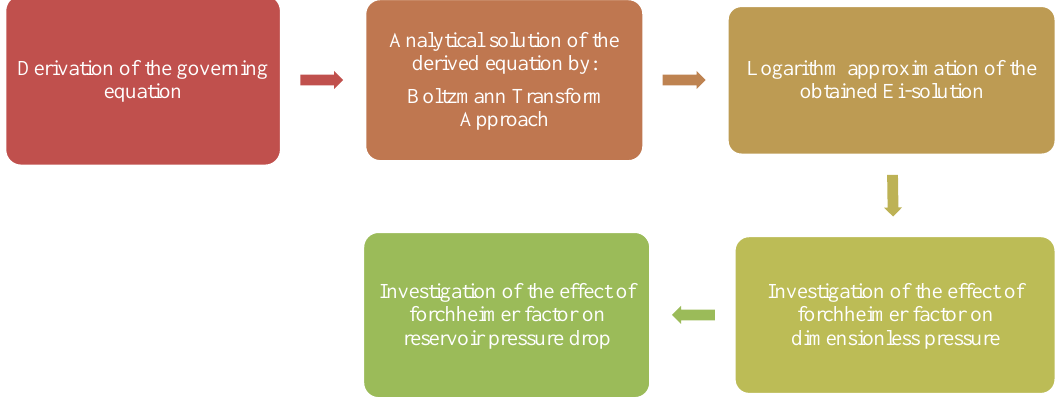
Figure 1. Flowchart of the research